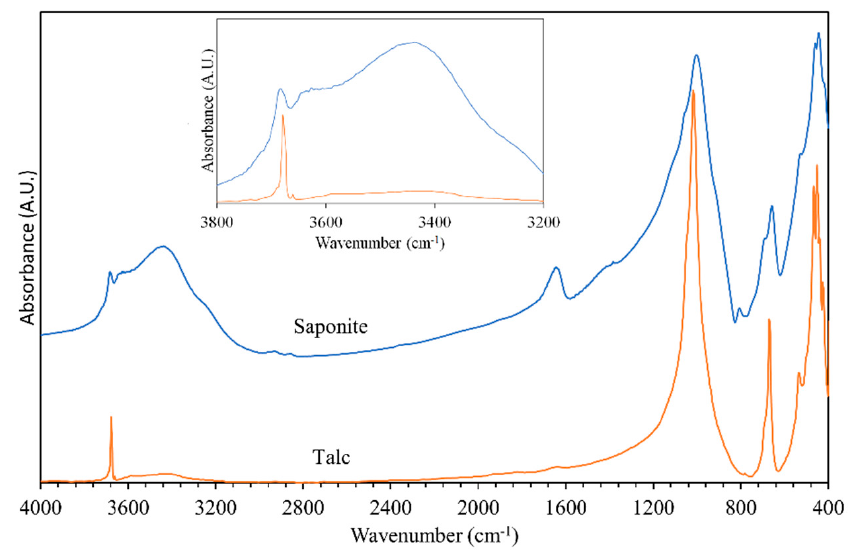
Figure 2. Infrared (IR) ATR spectra of saponite (Ballarat, CA, USA) and synthetic talc showing the Figure 2 . Infrared (IR) ATR spectra of saponite (Ballarat, California) and synthetic talc showing the broader and slightly shifted bands for saponite in comparison to broader and slightly shifted bands for saponite in comparison to talc.